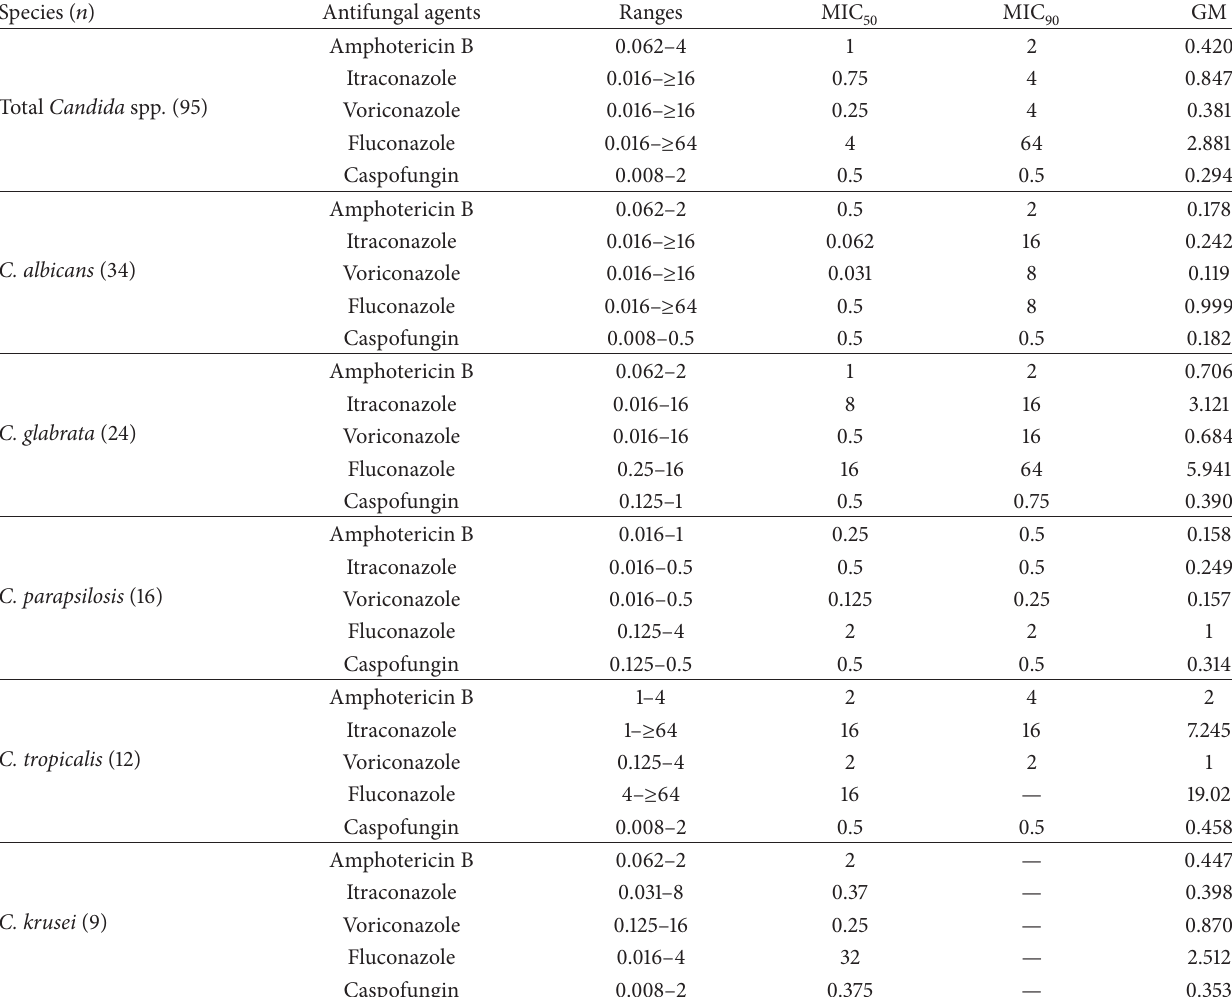
Table 1: In vitro susceptibilities of Candida spp. recovered from endotracheal tube to antifungal agents. MIC range, geometric mean, MIC 50 , and MIC 90 values are expressed in 𝜇